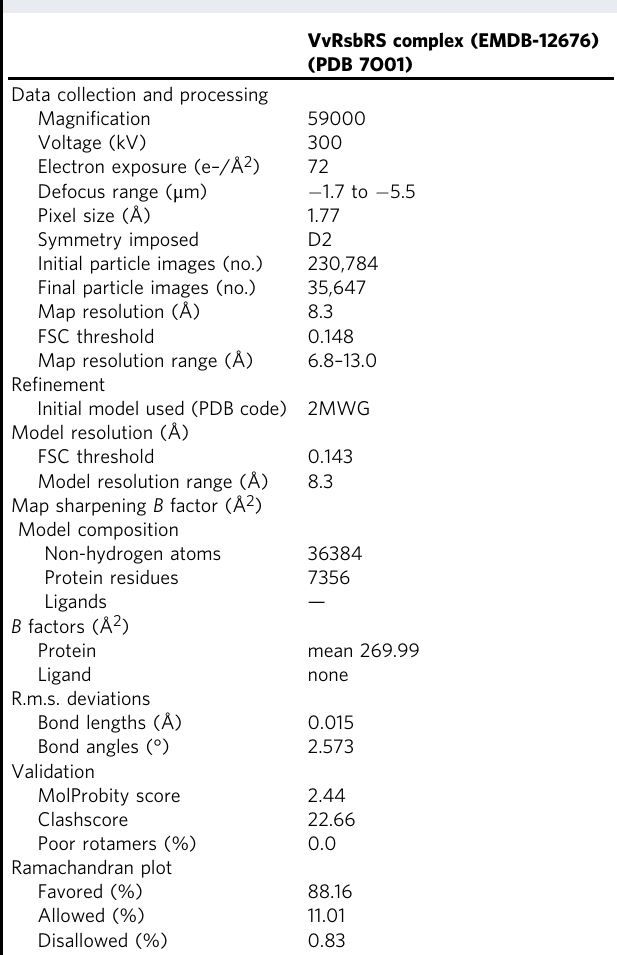
Table 1 Cryo-EM data collection, re fi nement and validation